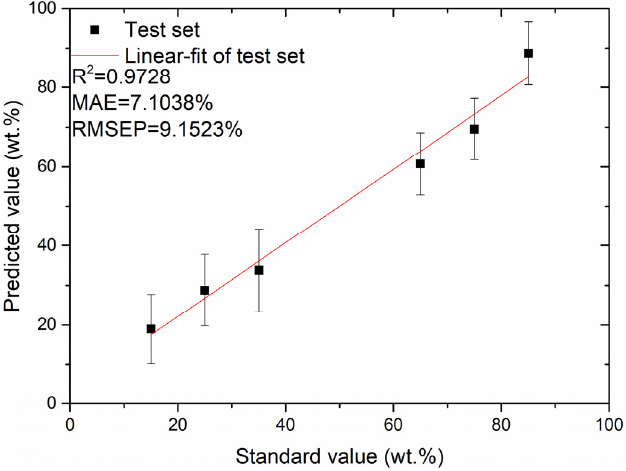
Figure 8. Plot between the predicted and standard values of the test set for the first 57 spectral features as inputs to the PLSR model.